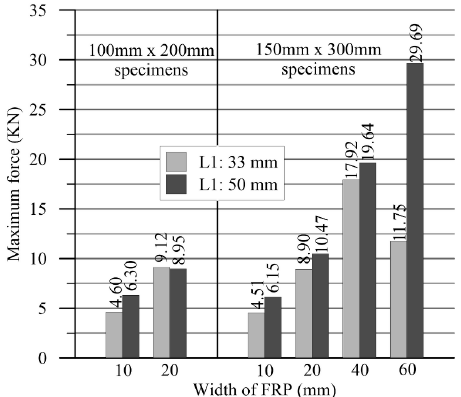
Figure 13. Influence of the bond length on the maximum debonding force.